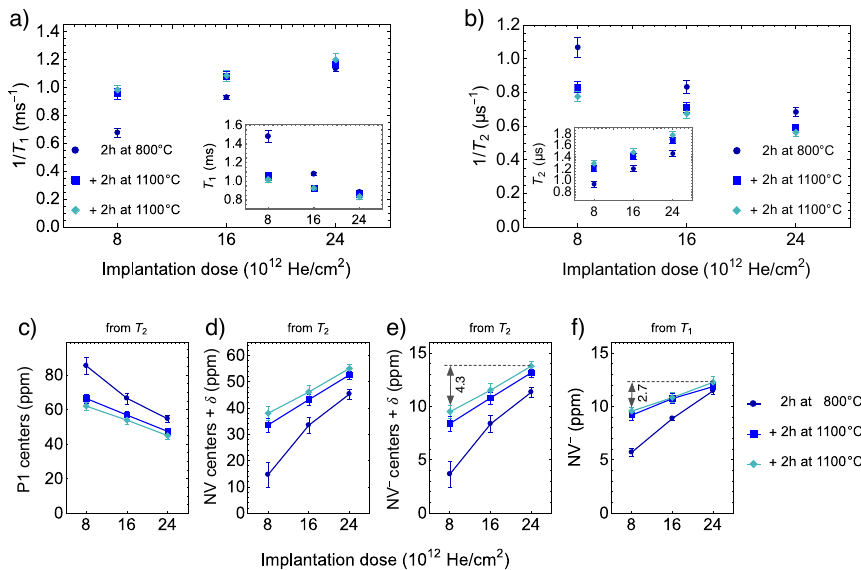
Figure 4. Relaxation measurements: ( a ) Relaxation rate 1/ T 1 for three subsequent annealing steps versus cumulative implantation dose. The inset shows the same plot in T 1 units. ( b ) Relaxation rate 1/ T 2 for three subsequent annealing steps versus cumulative implantation dose. The inset shows the same plot in T 2 units. Estimates of concentrations: ( c ) Concentration of P1 centers estimated from T 2 . ( d ) Concentration of NV centers estimated from T 2 . ( e ) Concentration of NV − estimated from T 2 . Symbol δ denotes small concentrations of other N-containing defects. ( f ) NV − concentration estimated from T 1 . All estimates are shown versus cumulative implantation dose for three subsequent annealing steps. The solid lines are shown to guide the